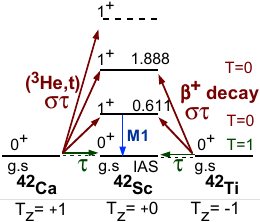
Figure 3. The 0 ◦ , 42 Ca( 3 He , t ) 42 Sc spectrum. Two prominent peaks observed in the low-energy region are the J π = 0 + IAS (g.s.) and the 0.611 MeV, 1 + LeSGT state excited with ∆ L = 0 transitions. No GTR structure, usually expected at observed.